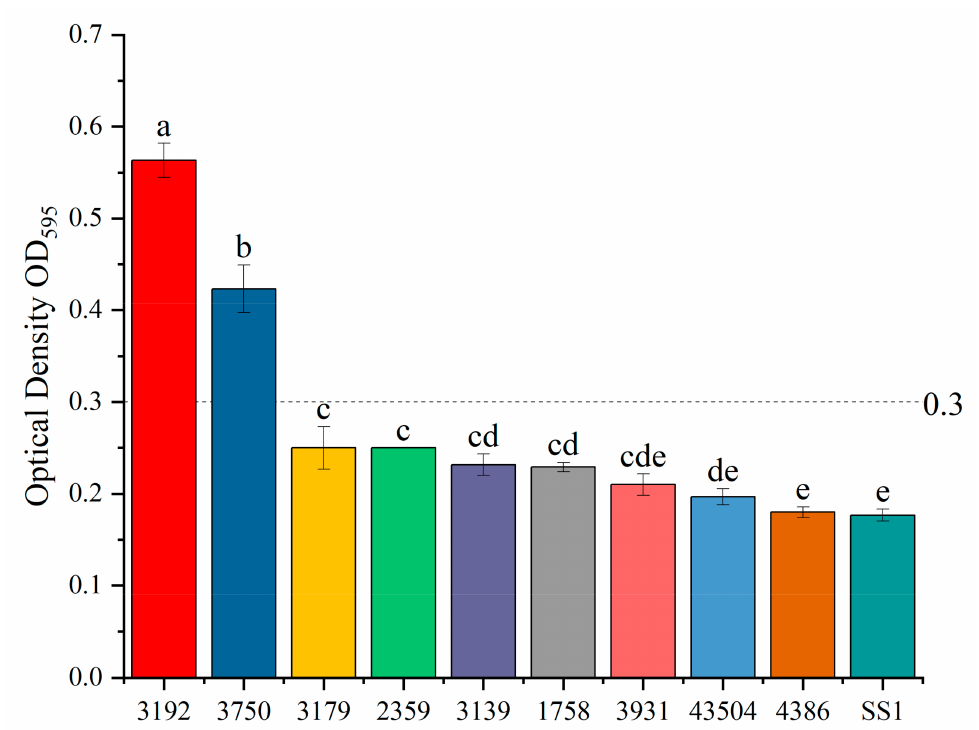
Figure 1. Distribution of biofilm formation in ten H. pylori strains. The biofilm-forming abilities of ten H. pylori strains were compared by crystal violet staining, and biofilm biomass was measured according to OD 595nm . OD 595nm 0.3 was regarded as the dividing line. All of the results are expressed as the means ± standard deviation from three independent experiments. The groups marked with different superscript letters indicate statistically significant differences ( p < 0.05).